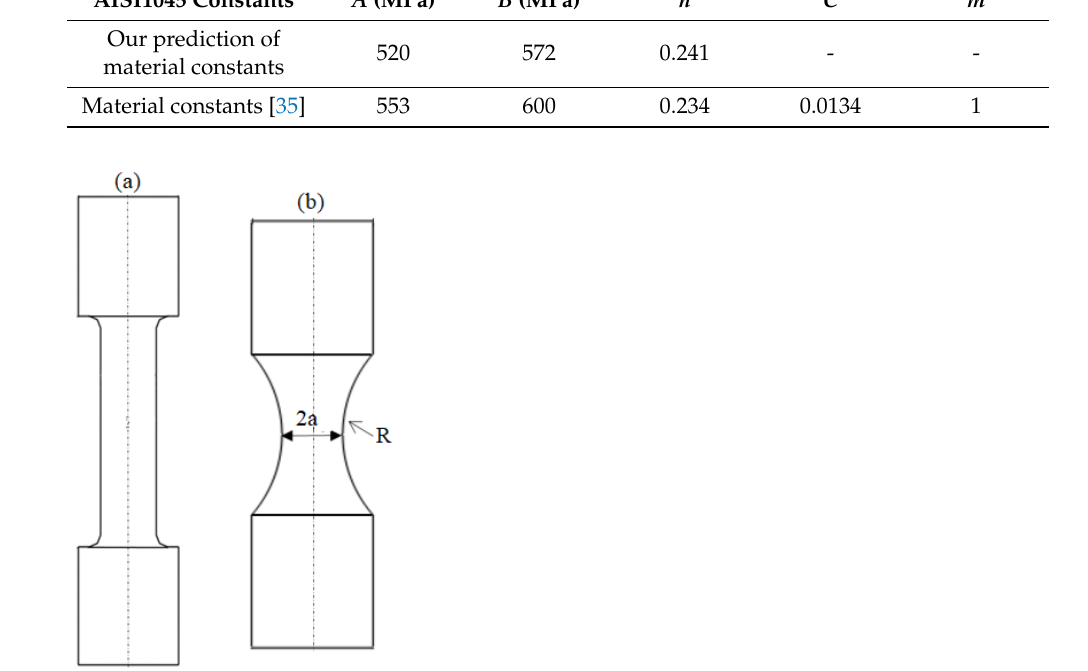
Table 5. Estimation of AISI1045 constants.